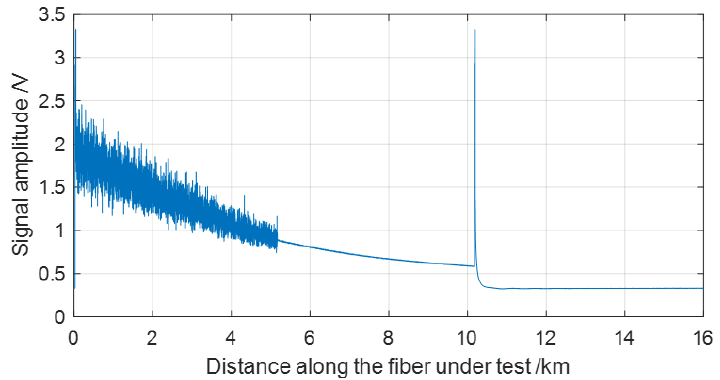
Figure 3. The OTDR trace after data averaging with the vibration event loaded.